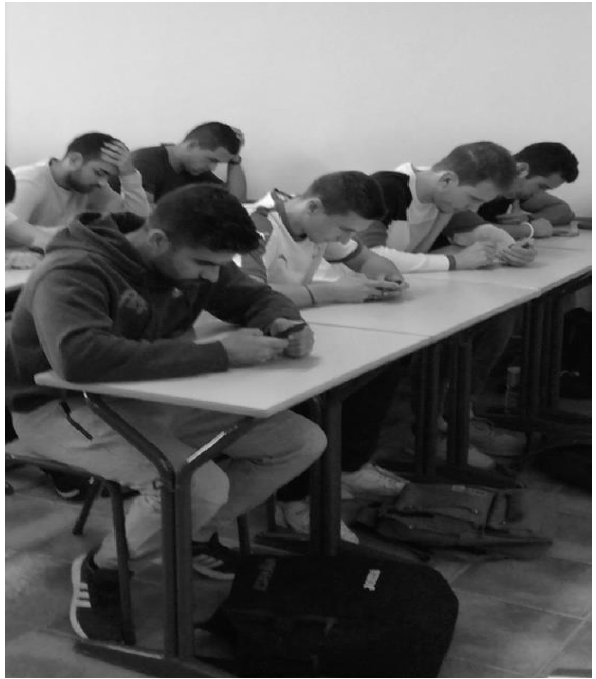
Figure 4. Experimental Set. Student performing the PVT (see text for full